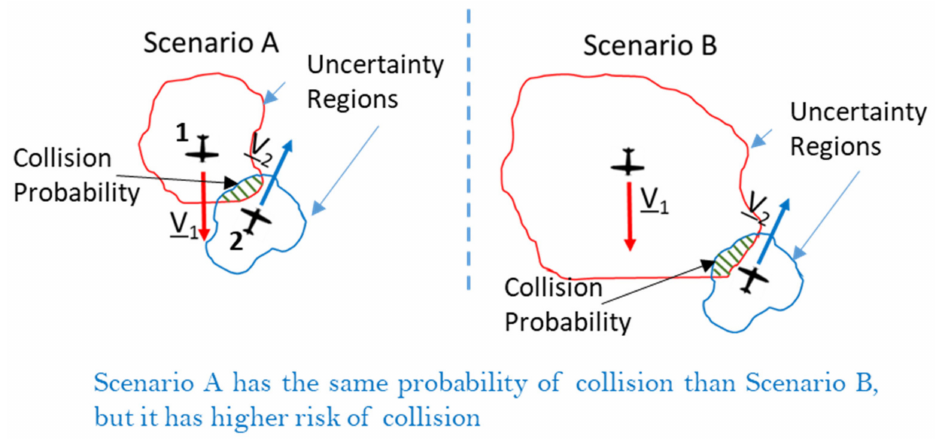
Figure 5. Computation of collision probability with two different prediction